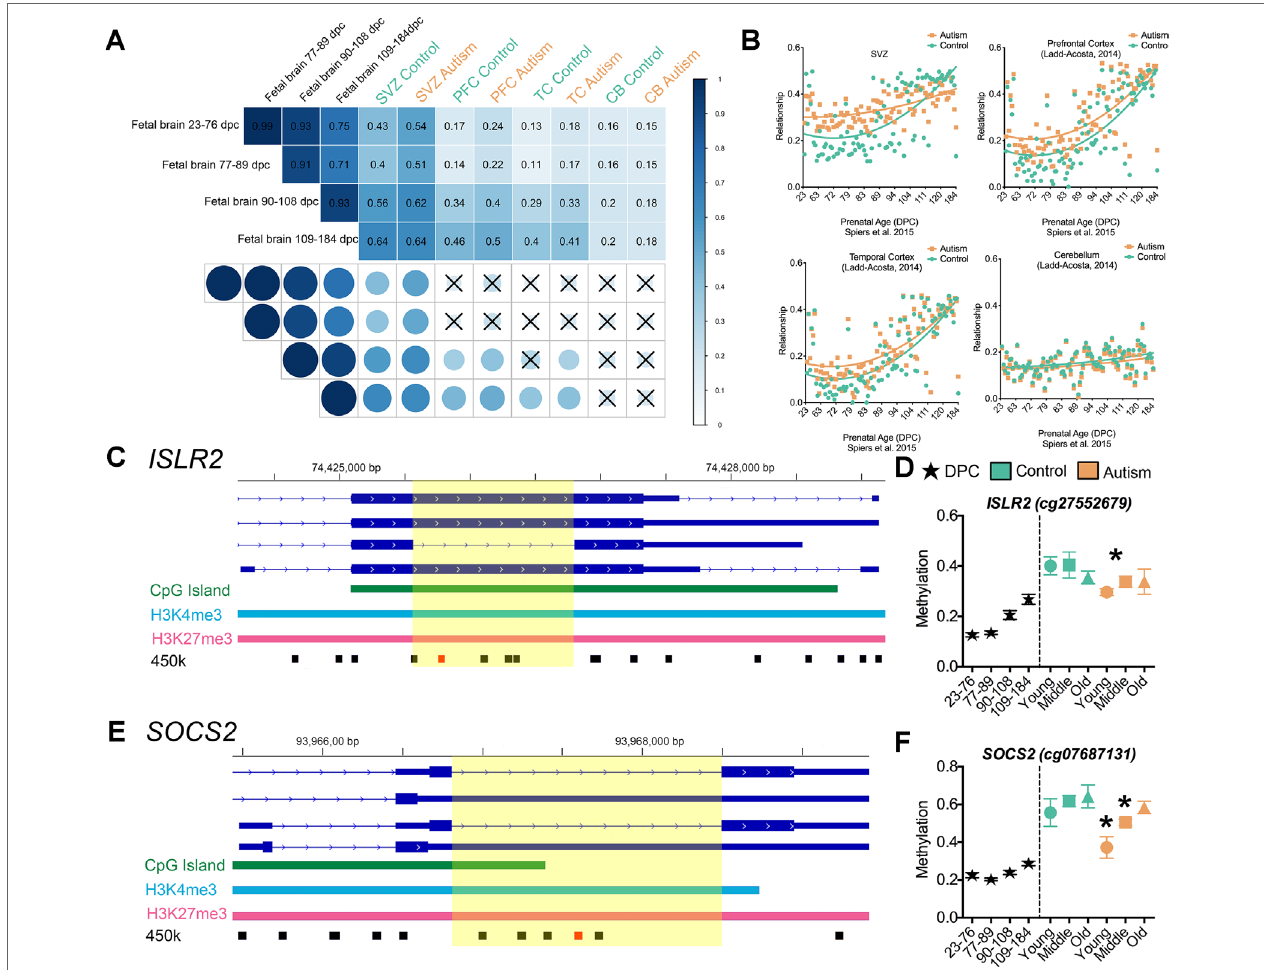
FIgURE 5 | Epigenetic delay of autism-associated DML. (A) Relationship between male fetal brain tissue specimens at four stages of development (days postconception, d.p.c.) and postmortem brain tissue from the subventricular zone (SVZ), prefrontal cortex (PFC), temporal cortex (TC), and cerebellum (CB) regions of typically developing (green) and autism-diagnosed (orange) specimens. Correlation matrix showing Pearson correlation coefficient and significance of relationship ( P < 0.001); X denotes nonsignificant. (B) Scatterplot of relationship of typically developing control (green) and autism (orange) methylation states at epigenetically dynamic regions versus male fetal brain methylation states from 23 days to 184 d.p.c. for SVZ, PFC, TC, and CB regions. (C) Scaled chromosomal view of location of DML in the ISLR2 gene. CpG island region indicated in green; bivalent domain indicated by H3K4me3 (light blue) and H3K27me3 (pink). Location of all 450k probes indicated in black and location of DML indicated in red. Yellow highlighted region shows DML overlaps with splicing event of exon. (D) DNA methylation at one CpG site on the 450k array within the EDR of ISLR2 progressively increased from low (~18%) to intermediate (~40%) levels during fetal brain development and in postnatal SVZ of typically developing control brain. The methylation level at this site in the SVZ from ASD cases remained low (~30%; ASD young cases), resembling that of fetal brain tissue at 109–184 d.p.c. (E) Scaled chromosomal view of location of DML in the SOCS2 gene. CpG island region indicated in green; bivalent domain indicated by H3K4me3 (light blue) and H3K27me3 (pink). Location of all 450k probes indicated in black and location of DML indicated in red. Yellow highlighted region shows DML overlaps with splicing event of exon. (F) DNA methylation level at one CpG site on the 450k array within the EDR of SOCS2 increased from ~20 to ~65% pre- to postnatally in normal brain, while it remained at ~40–50% in postnatal SVZ of ASD cases. *, denotes significant methylation difference at P < 0.05 between control and autism